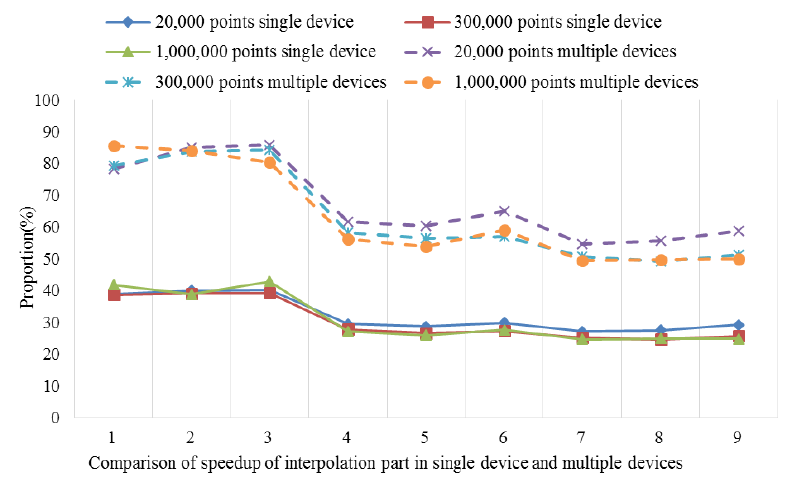
Figure 9. Comparison of the speedup obtained using single/multiple cards on Shelob ( Speedup I ).